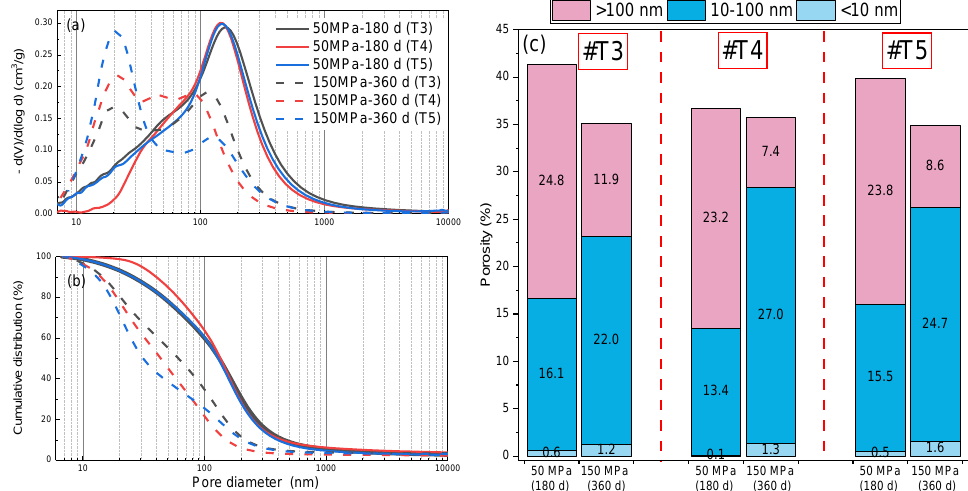
Figure 10. MIP test results of slurries T3 to T5 showed higher curing pressure resulted in smaller pore size and lower porosity in long-term cured samples. ( a ) Pore size distribution frequency curve. ( b ) Cumulative pore size distribution curve. ( c ) General pore size statistics. (Note: it is expected that the pore size and porosity of the 50 MPa samples at 360 d would be larger than those measured at 180 d according to the trend shown in Figure 3).